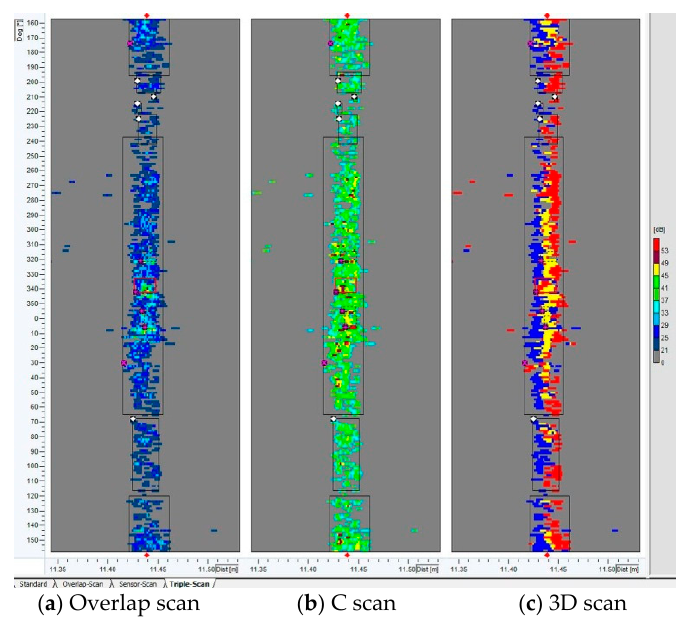
Figure 13. Signal characteristic of a premade girth weld defect during ultrasonic in-line inspection. ( a ) Overlap scan; ( b ) C scan; ( c ) 3D scan.